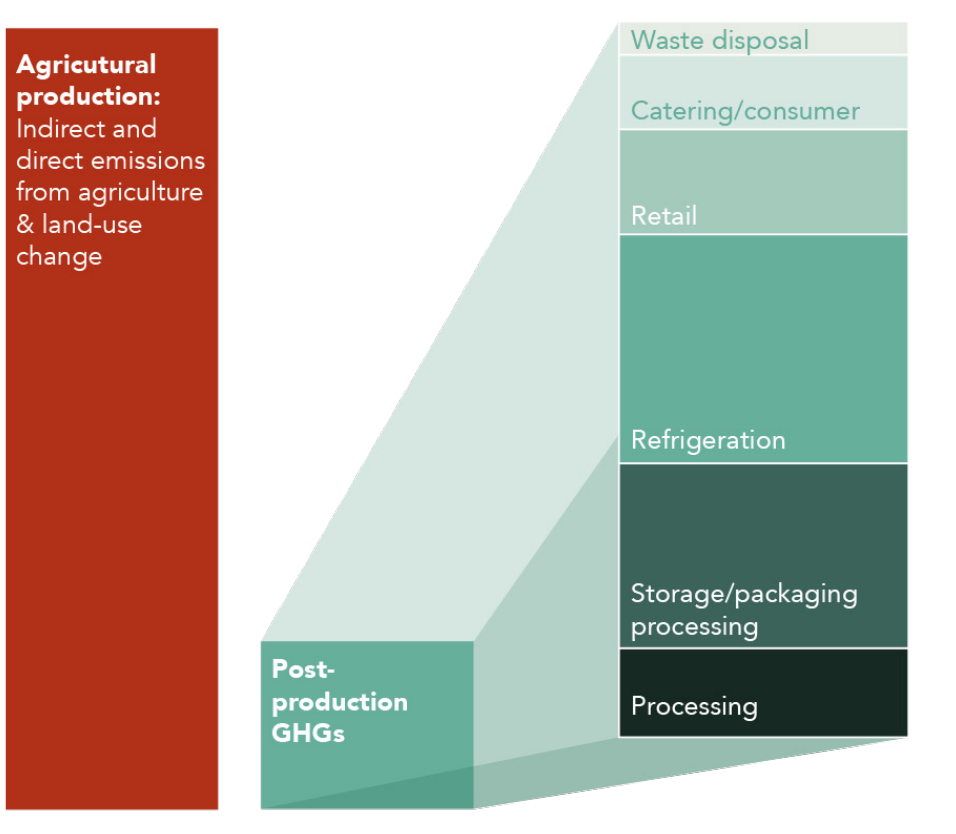
Figure 3: A comparison of emissions from agricultural production to post-production